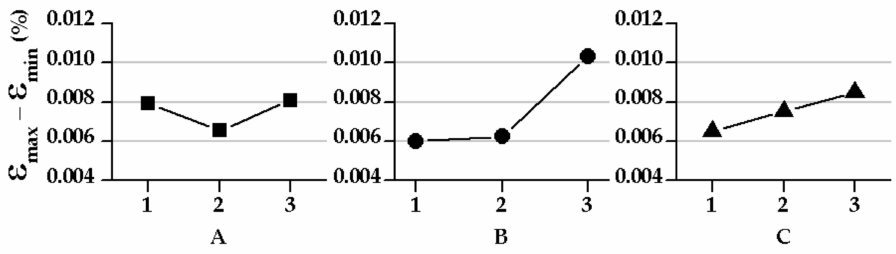
Figure 9. Sensitivity analysis considering interactions based on factor levels in Table 2.